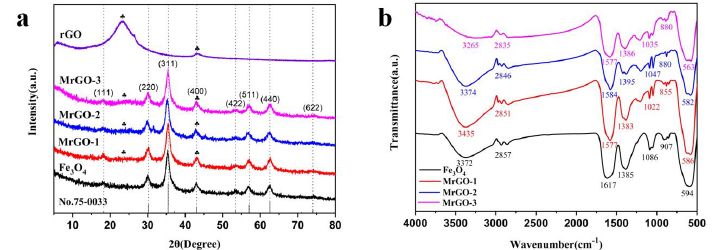
Figure 2. ( a ) XRD patterns of materials; and ( b ) FTIR spectra of materials.